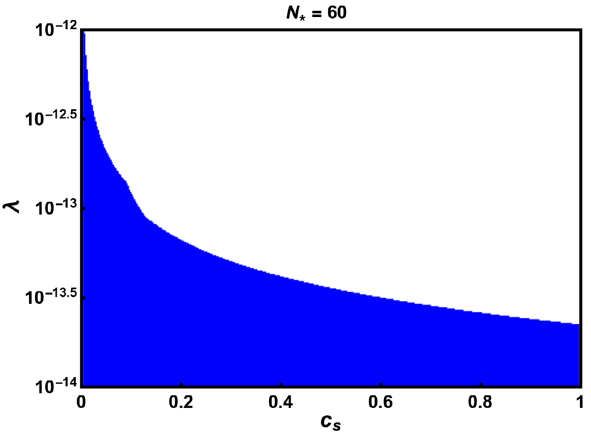
Fig. 6 Same as Fig. 5, but for N ∗ =